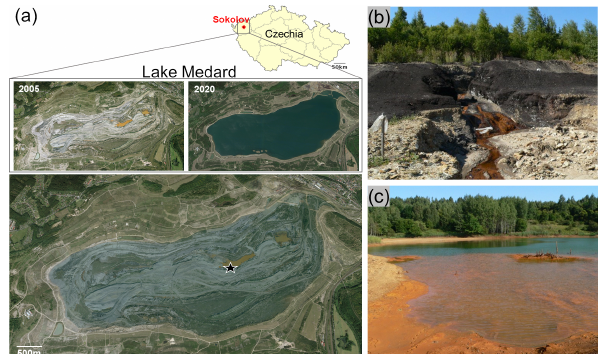
Figure 1. The area now occupied by the post-mining Lake Medard was previously an open-cast coal mine near Sokolov, NW Czechia. Upon mine abandonment, the deepest parts of the open-cast mine became shallow acidic pit lakes and are now the lake depocentres. The deeper zone of the lake now features ferruginous and sulfate- rich aqueous conditions, but the pH is circumneutral. The star marks the central sampling location in a recent lake imagery superim- posed on the 2005 mine-pit imagery (a) . The mine pit had impor- tant fluxes of solutes linked to pyrite oxidation in exploited coal seams and their associated pyrite-bearing lithologies (b–c) . These fluxes may still affect the hydrochemistry of the present-day lacus- trine system; i.e., solutes are currently sourced from now submerged lithologies that also bear pH-neutralizing carbonates (Appendix A). Imagery dates 19 May 2020 (© CNES/Airbus) and 1 January 2004 (© GEODIS Brno). Historical photographic record by courtesy of the Czech Geological